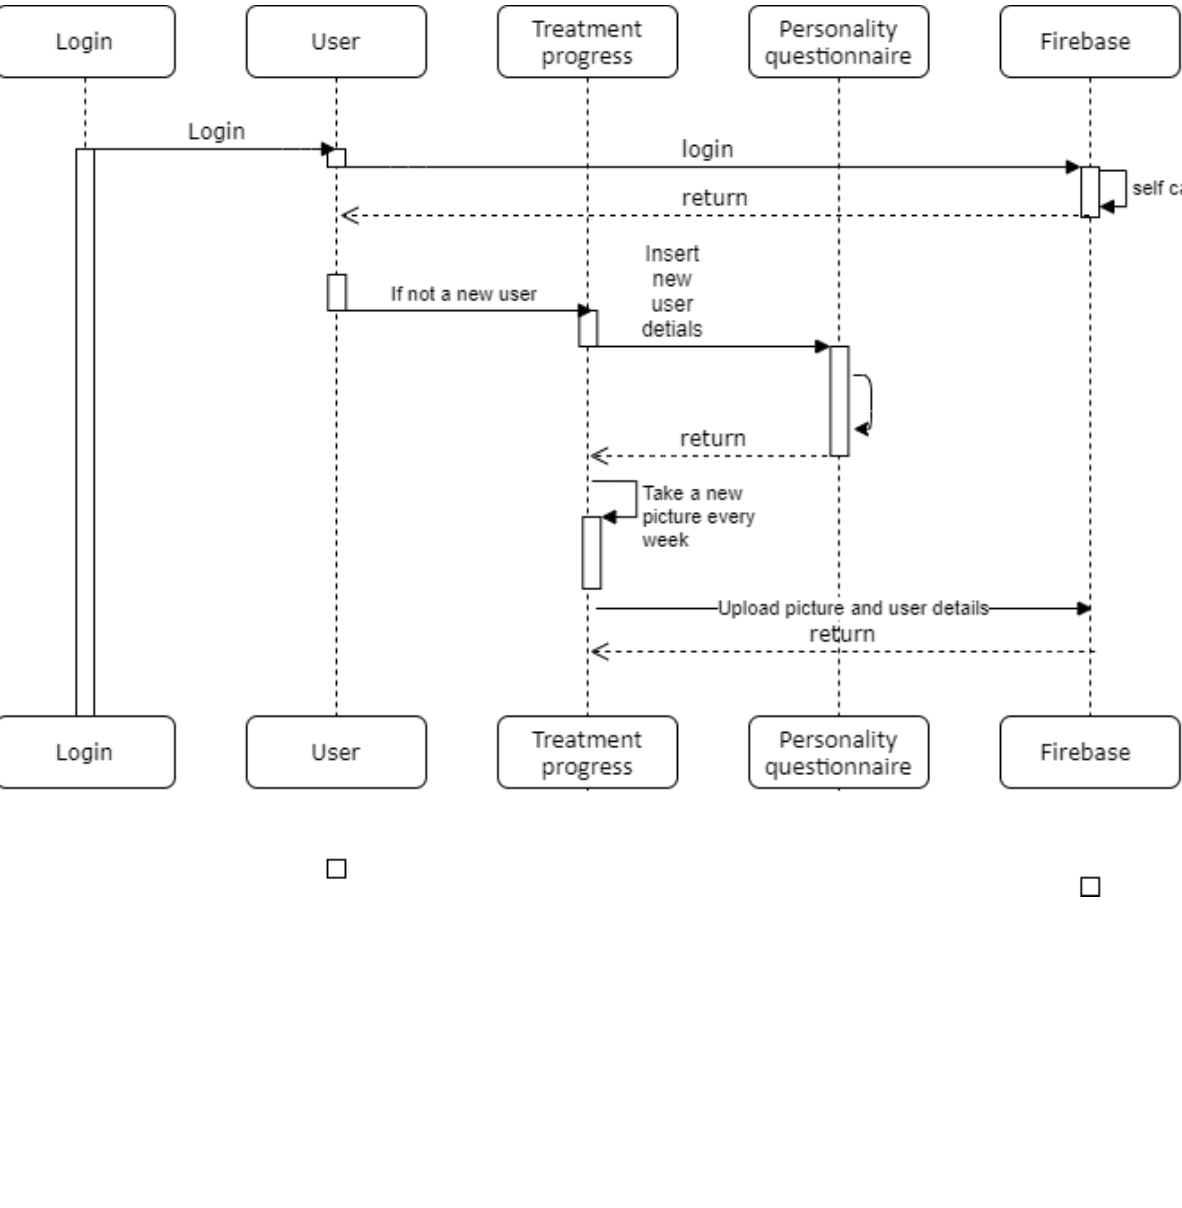
Figure 22. Sequence diagram of the patient’s use processes with the app; DB: